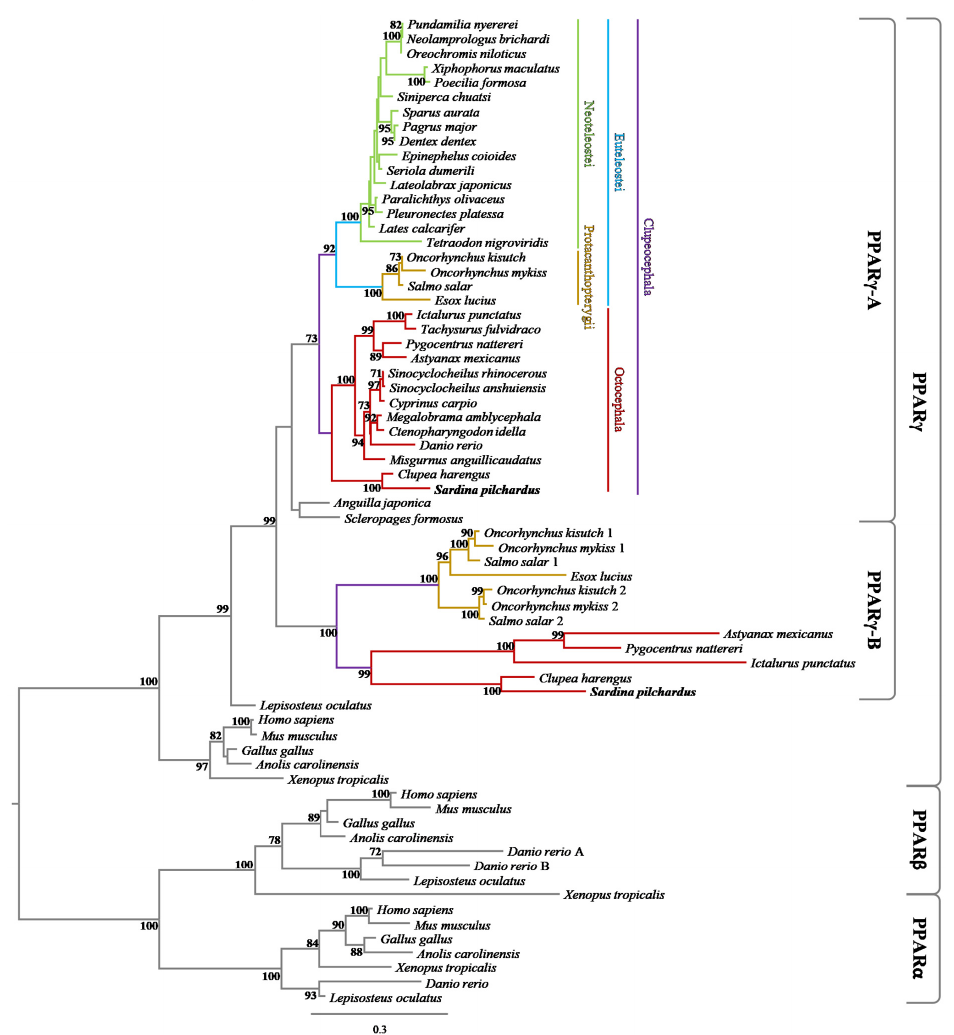
Figure 1. Maximum likelihood phylogenetic analysis of PPAR γ A and PPAR γ B paralogous genes. The numbers at the nodes indicate bootstrap support values.